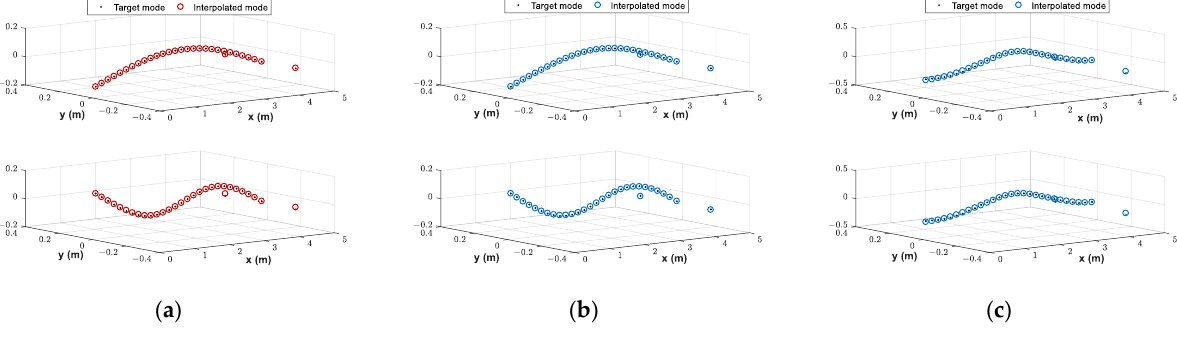
Φ Φ Φ a and (cid:101) a . ( b ) c and (cid:101) c .